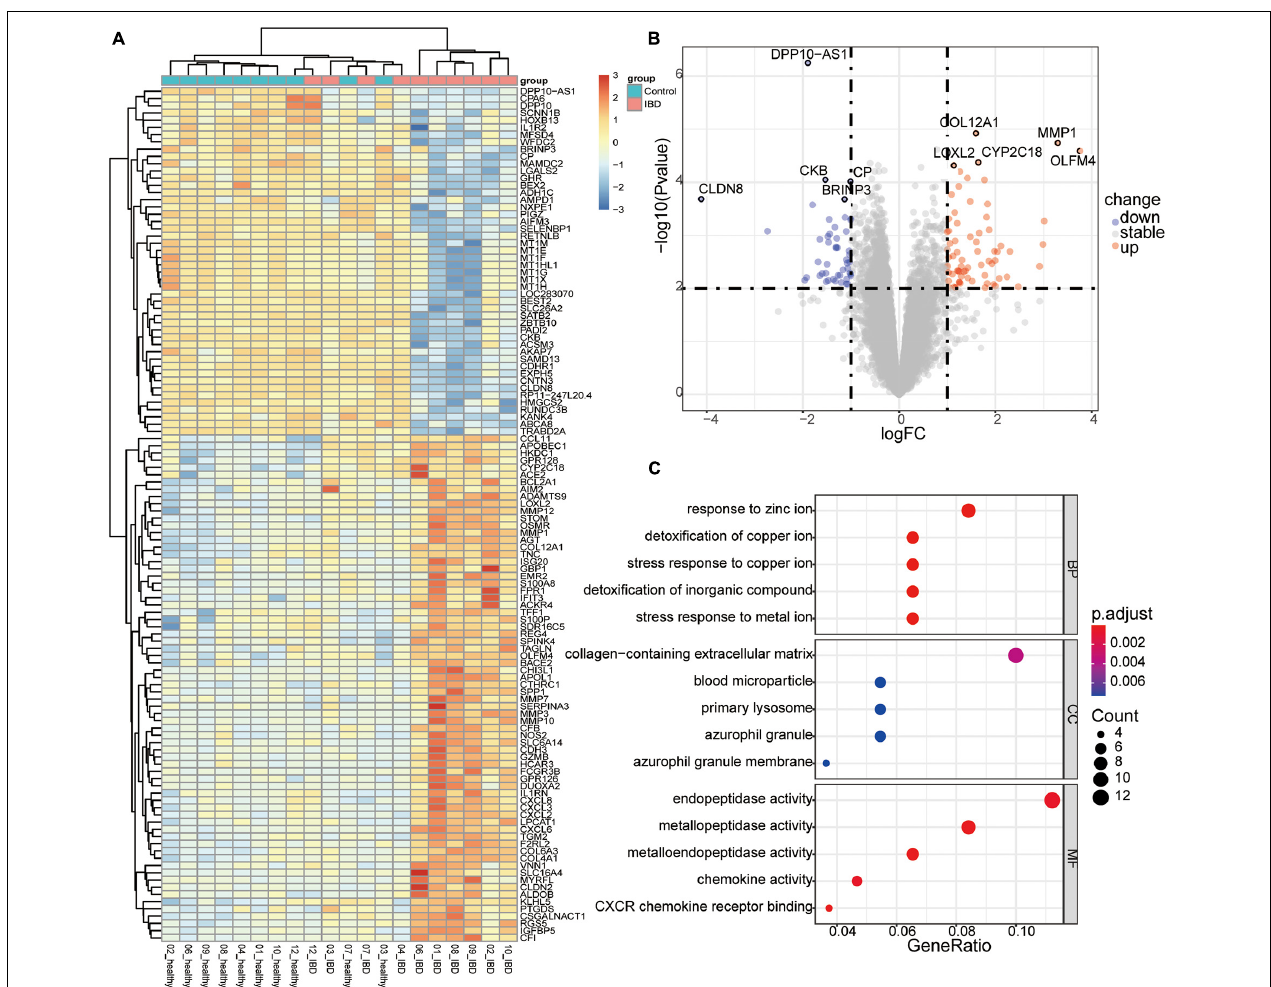
FIGURE 2 | Differentially expressed genes (DEGs) in the discordant inflammatory bowel disease (IBD) twin pairs. (A) Heatmap of the scaled expression values of DEGs. (B) Volcano plot of the DEGs, with the top five upregulated and downregulated genes labeled. (C) Enriched components containing the